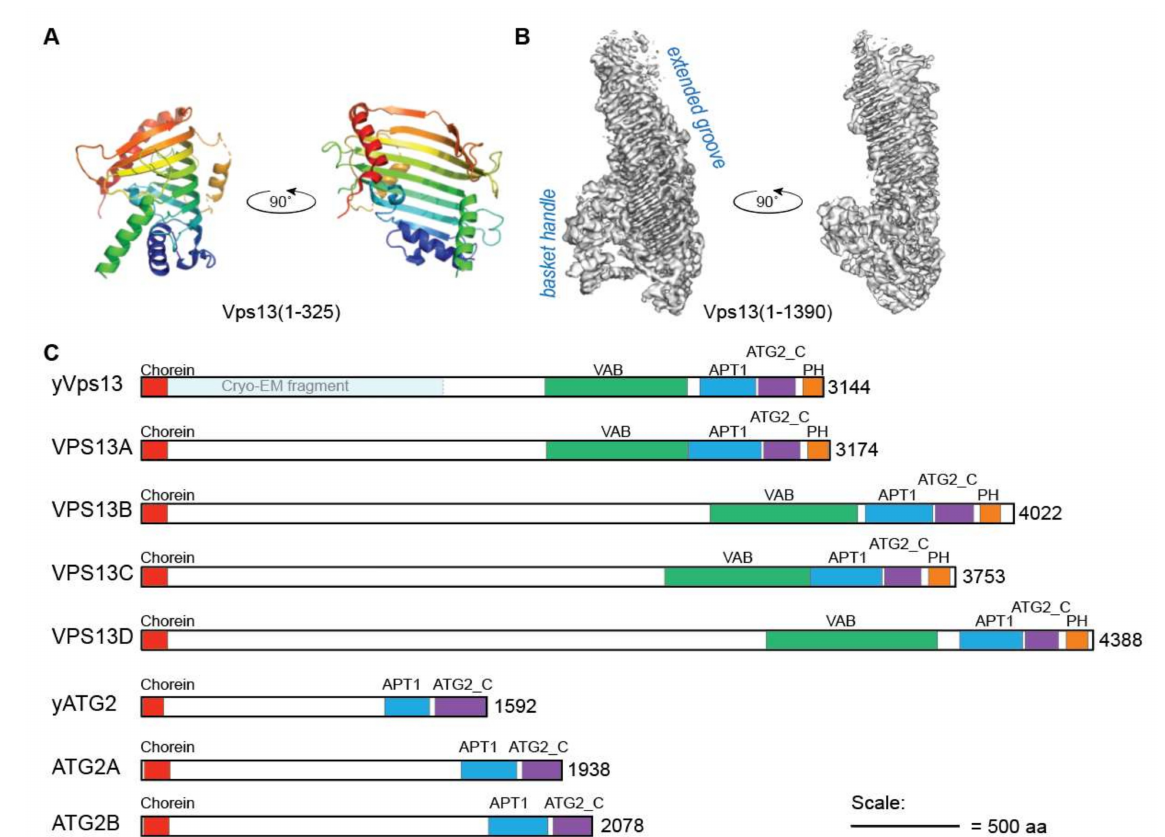
Figure 1. Domain architecture of VPS13 and ATG2 proteins. ( A ) Ribbon models of the crystal structure of residues 1-325 of C. thermophilum Vps13 lacking residues 95-132 (Protein Data Bank accession No. 6CBC) [15]. Residues are coloured blue to red from 1 to 325. ( B ) Cryo-EM structure of residues 1-1390 of C. thermophilum Vps13 (EMD-21113, 3.75 Å resolution) [37]. ( C ) Shared conserved domains of S. cerevisiae and human VPS13 and ATG2 proteins drawn approximately to scale. Domains occurring in individual proteins, such as the ubiquitin-associated (UBA) domain of VPS13D, are not shown. Domains and abbreviations are as follows: Chorein domain; VAB, Vps13 Adaptor Binding/WD40 domain; APT1 domain; ATG2_C, Autophagy-related protein 2 C -terminal domain; and PH, Pleckstrin homology domain. The region of yeast Vps13 corresponding to the cryo-EM structure of C. thermophilum Vps13 [37] is shown in pale